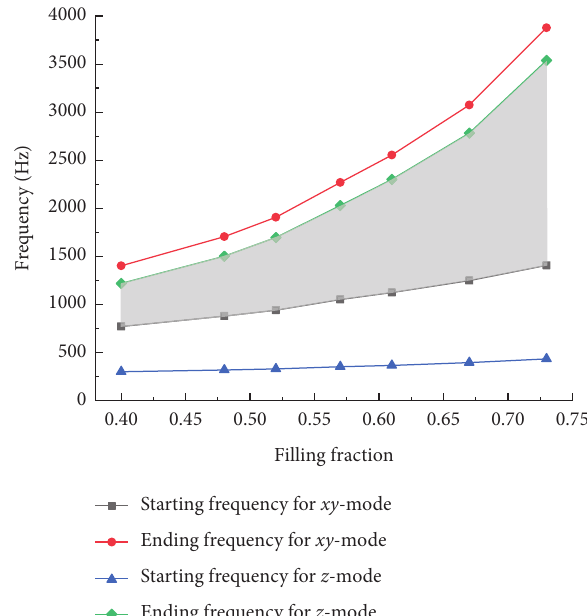
Figure 6: Effect of elastic modulus of matrix on boundary fre- quencies of the 1st complete band gaps.